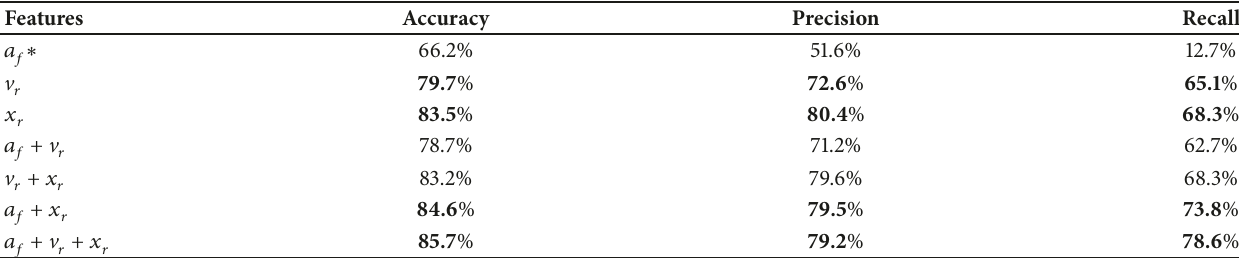
Table 7: The evaluation results of driving style based on SVM using the statistical method.